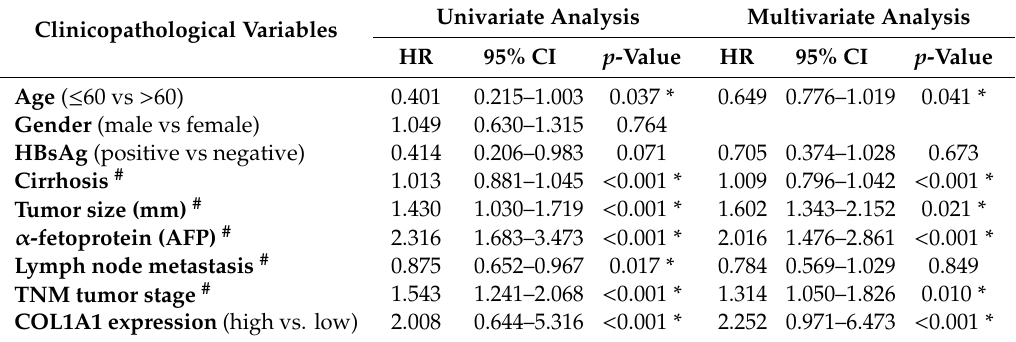
Table 2. Univariate and multivariate analysis of COL1A1 expression in TMU-SHH HCC